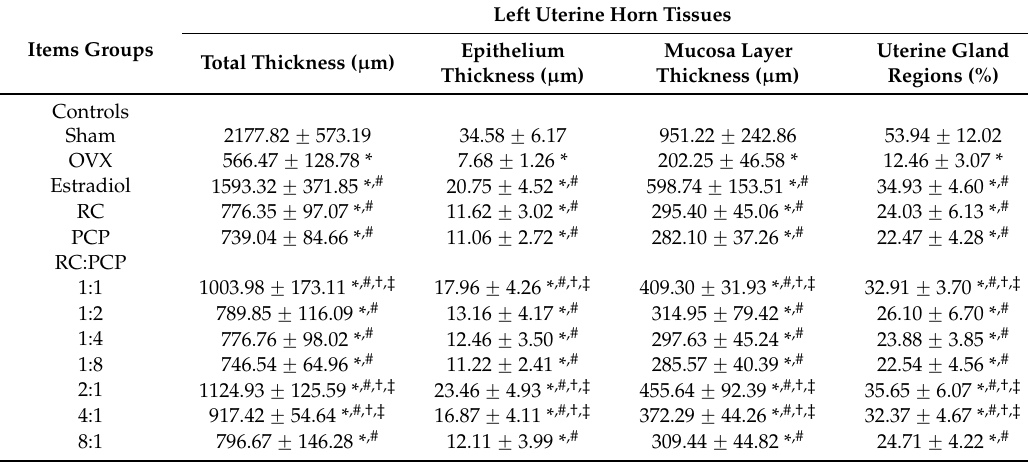
Table 5. Histopathology-Histomorphometry for the uterus in sham-operated or OVX ddY